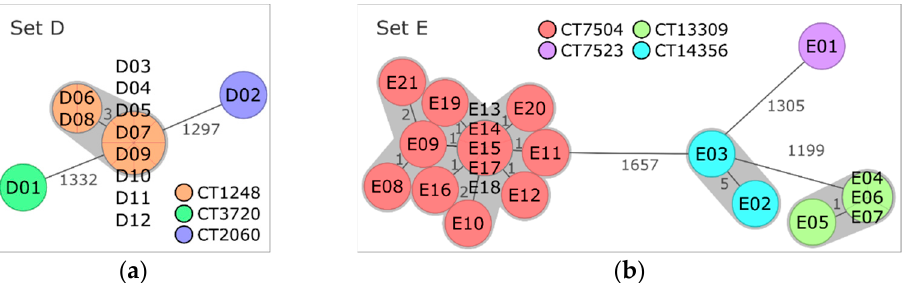
Figure 3. Minimum spanning trees based on core genome multilocus sequence typing (cgMLST) of ( a ) set D isolates obtained from processing plant 2 and ( b ) set E isolates from processing plant 3. Isolates are represented in circles, which are colored according to their cgMLST type (CT). The number of allelic distances are shown next to the lines connecting the respective isolates. Clusters with allele difference ≤ 10 are shaded in gray.